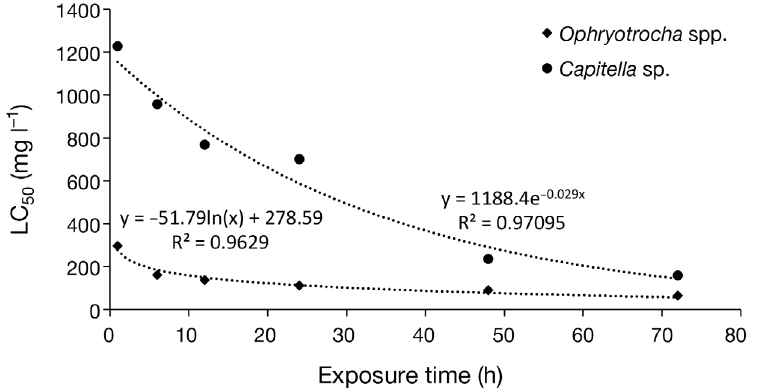
Fig. 2. Lethal concentration (LC 50 , mg l − 1 ) of the polychaete species Capitella sp. and Ophryotrocha spp. exposed to hydrogen peroxide at in- creasing time intervals after exposure. The equations stem from the results of curve estimation analysis of the relationship between LC 50 and time